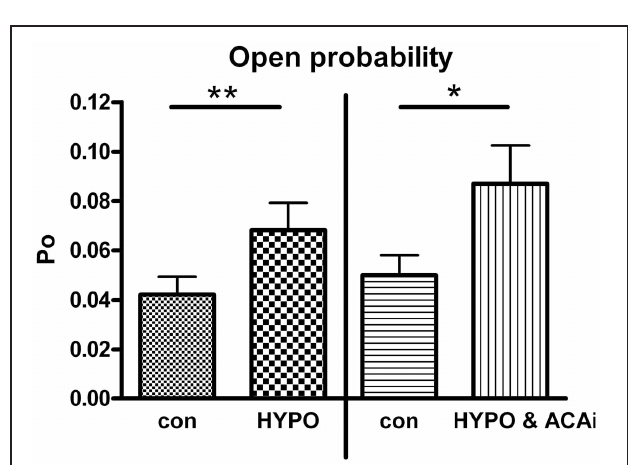
FIGURE 5 | Effect of internal ACA on hypotonicity induced BK channel activation. BK channel open probability was significantly increased by a hypotonic solution at 1.2 μ M [Ca 2 + ]i (left panel, Paired Student’s t -test: ∗∗ p < 0 . 01, n = 4). Internal ACA (ACAi) did not affect this hypotonicity induced activation (right panel, Paired Student’s t -test: ∗ p < 0 . 05, n = 12).